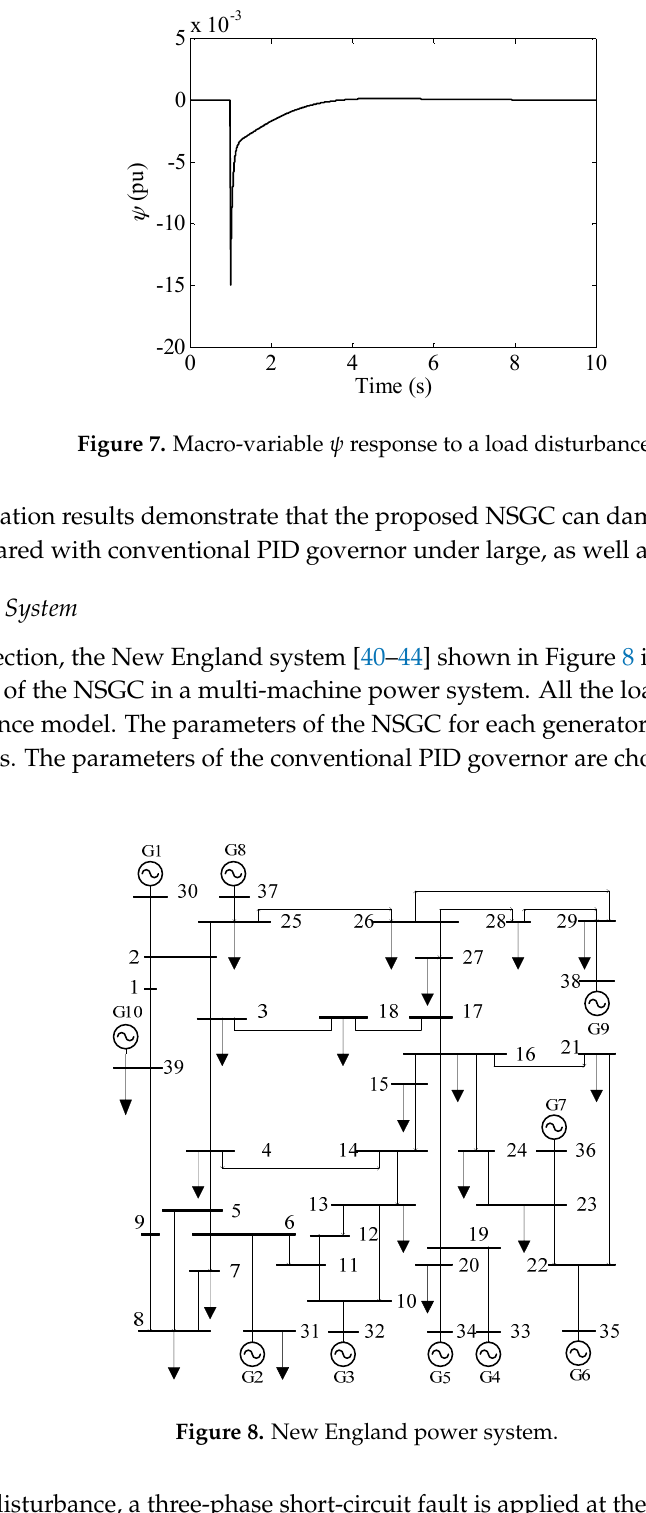
Figure 8. New England power system.